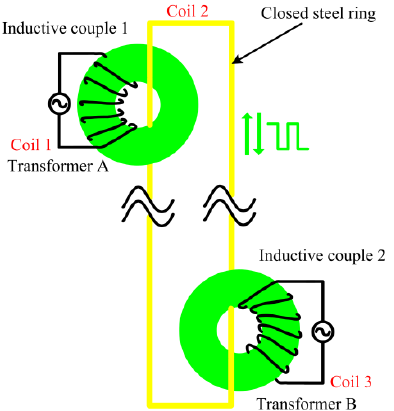
Figure 6. A schematic diagram of power feeding and data transmission.